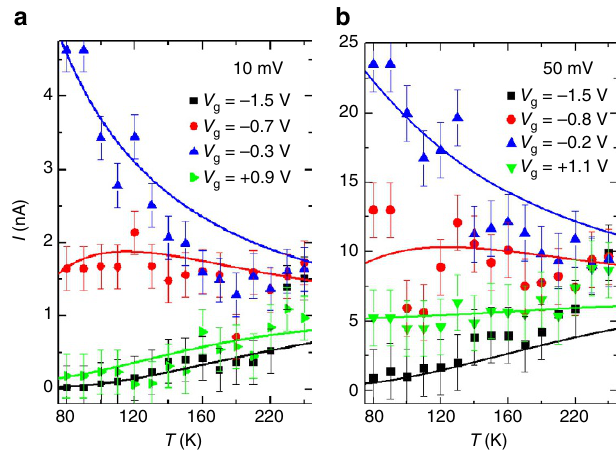
Figure 5 | Tunnelling current as function of temperature and applied bias. ( a ) Evolution of the tunnel current with temperature at V sd ¼ 10mV for four different gate voltages ( V g ¼ (cid:2) 1.5, (cid:2) 0.7, (cid:2) 0.3 and þ 0.9V). ( b ) Same for V sd ¼ 50mV ( V g ¼ (cid:2) 1.5, (cid:2) 0.8, (cid:2) 0.2 and þ 1.1V). The solid lines in both panels represent fittings to the single-level tunnelling transport model in equation (1) with the parameters given in Table 1. The error bars represent the uncertainty in the determination of the value of the tunnelling current due to the noise of the for V g ¼ (cid:2) 0.7 V and V sd ¼ 10 mV (Fig. 5a) and V g ¼ (cid:2) 0.8 V and V sd ¼ 50 mV (Fig. 5b). In this regime, I depends weakly on T .